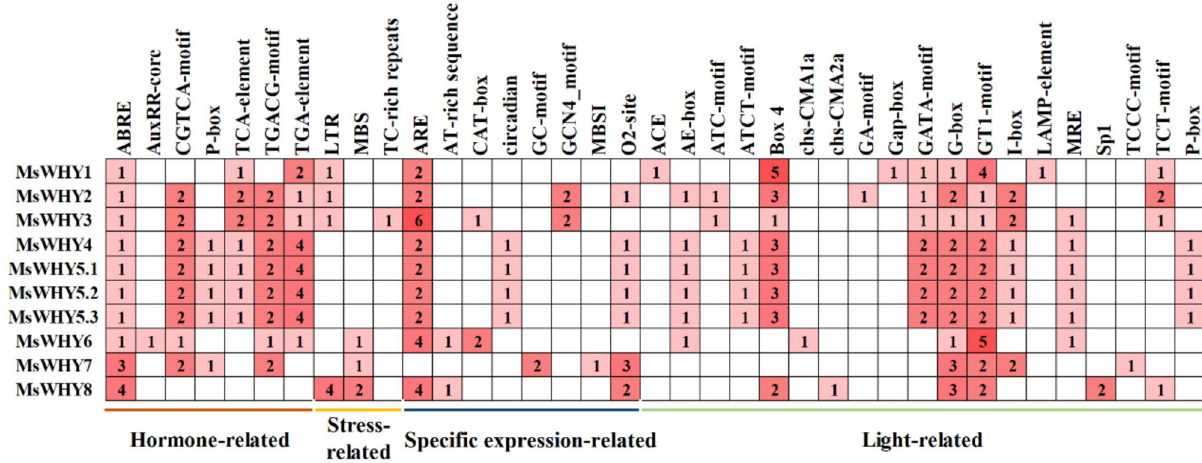
Figure 5. Putative cis-acting regulatory elements (CAREs) of the MsWHY gene family. The CAREs analysis was performed with the 2 kb upstream region using the PlantCARE online server. Hormone-responsive elements, stress-responsive elements, specific expression-related elements, and light-responsive elements are shown in different